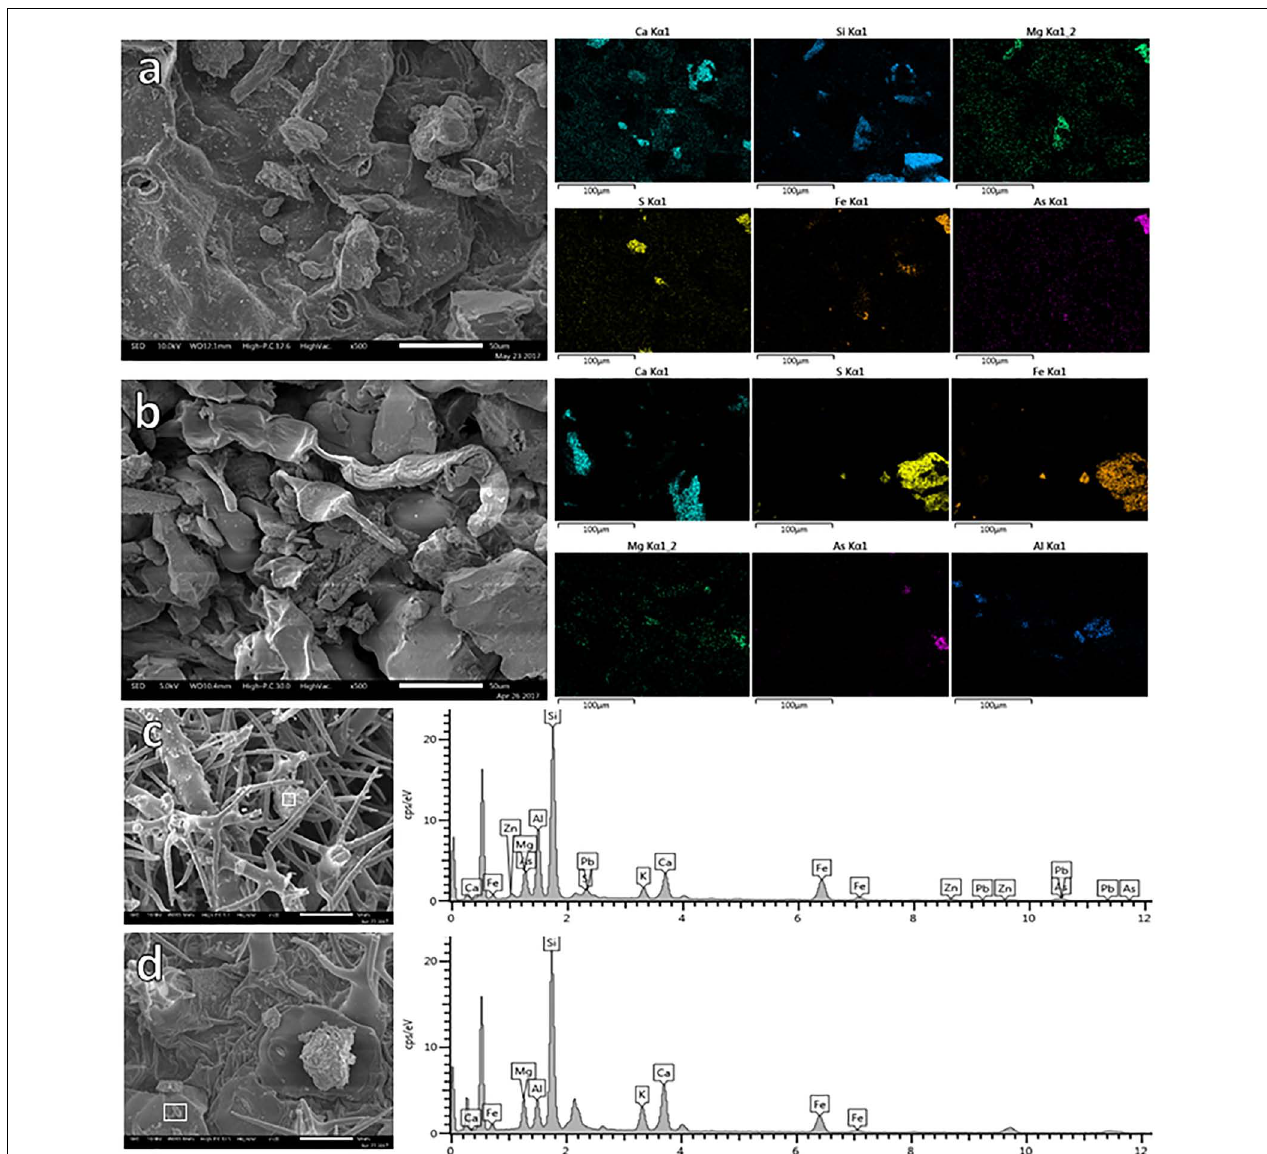
FIGURE 3 | EDX-mapping of leaf surface of Flaveria trinervia collected on control site (a) and mine residues (b) . EDX-spectrum of specific particles (white square) retained on leaves of Gnaphalium sp. growing on mine residues (c) or in the non-contaminated control site (d) .